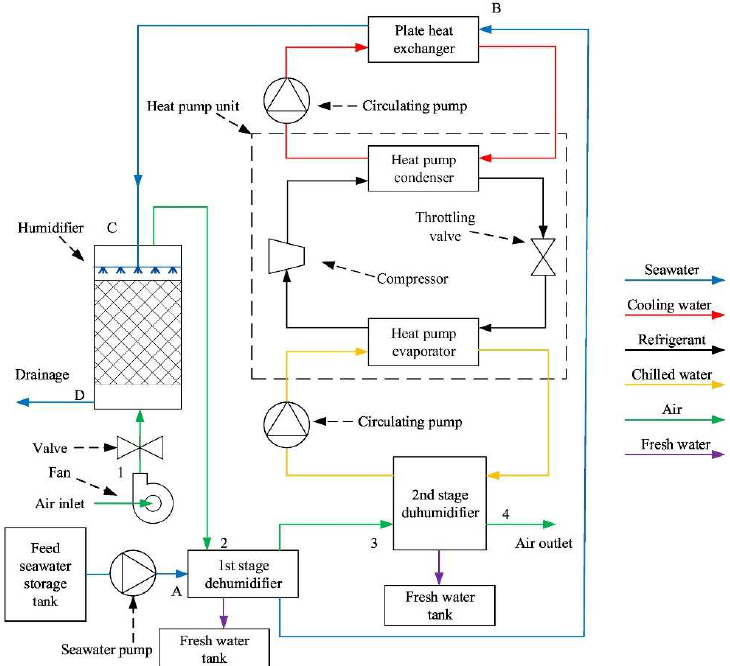
Figure 16. Diagrammatic representation of the suggested system by [301]. Reproduced with permission from Yin Zhang, Chunguang Zhua, Huan Zhang, Wandong, Zheng, Shijun You, Yuhan Zhenac, Desalination Journal, published by Elsevier, 2018 [301]. Table 11. A concise summary of the experimental literature pertaining to the hybrid HD method. Major Conclusions